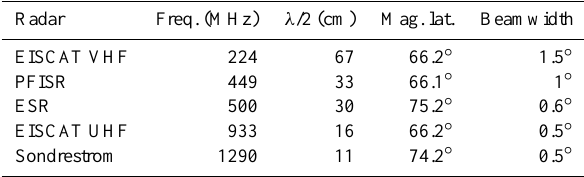
Table 1. Summary of the characteristics for the main high-latitude radars, specifically the operating frequency, the Bragg scattering scale length ( λ /2), the magnetic latitude and the beam